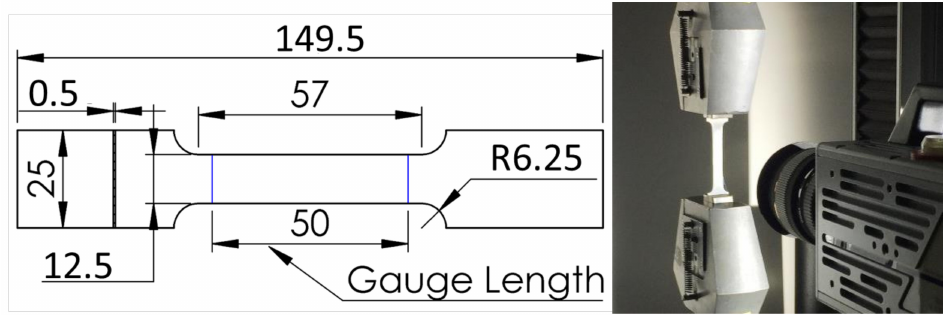
Figure 1. ( Left ) Specimen design following ISO 6892-1:2016; dimensions in mm. ( Right ) Set-up for tensile test.